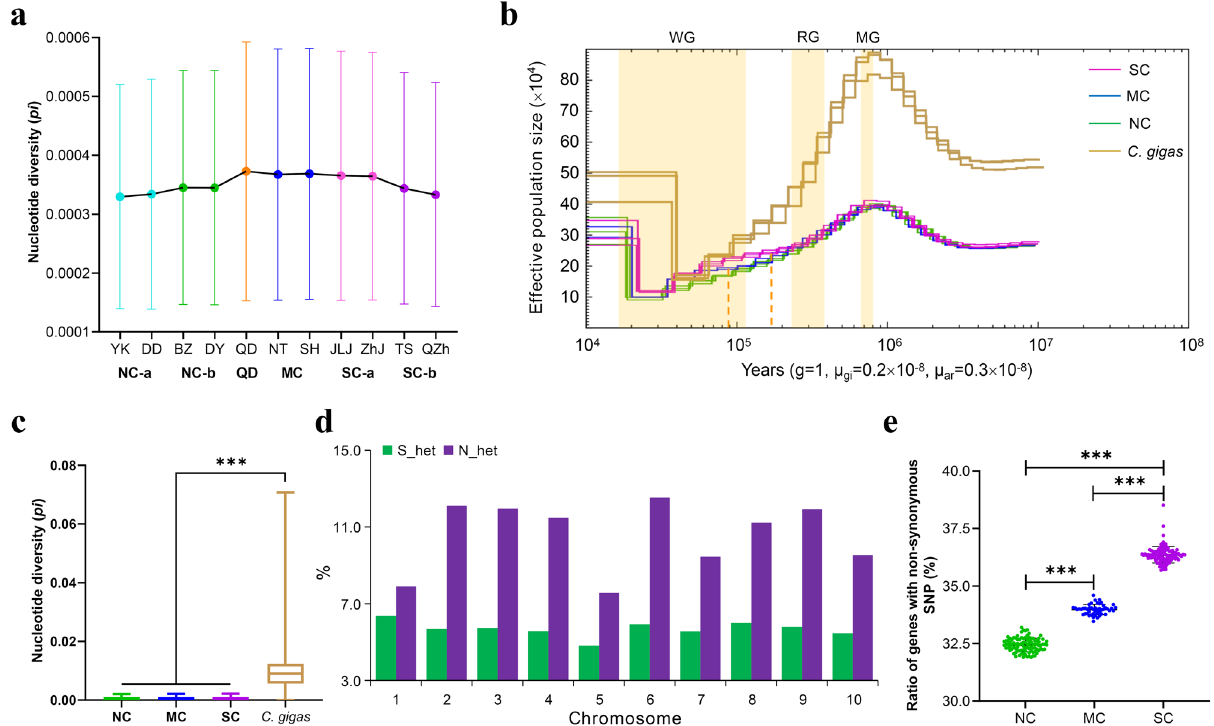
Fig. 3 Effects of gene fl ow, historical glaciation and natural selection on diversity and differentiation of the estuarine oyster. a Nucleotide diversity ( pi ) in 11 geographic populations along the coast of China. b Demographic histories of three populations of the estuarine oyster (ar) (SC, MC and NC), and Paci fi c oyster ( C. gigas or gi) inferred by Pairwise Sequentially Markovian Coalescent. Periods of the Mindel glaciation (MG, 0.68~0.80 mya), Riss glaciation (MG, 0.24~0.37 mya) and Würm glaciation (WG, 10,000~120,000 years ago) were shaded by yellow. c Nucleotide diversity ( pi ) of three populations of the estuarine oyster, and Paci fi c oyster ( C. gigas ). The data are presented as box plots; the central rectangle spans the fi rst to third quartiles of the distribution, and the ‘ whiskers ’ above and below the box show the maximum and minimum estimates. The line inside the rectangle shows the median, the circles represent outliers. d The ratio of SNPs that are highly heterozygous only in northern (N_het) or only in southern (S_het) populations across 10 chromosomes. e The ratio of genes with non-synonymous SNPs in three oyster populations. Data are presented as circle plot, with each circle representing an individual oyster and bars showing the mean value ± SEM. Asterisks indicate signi fi cant difference (*** p < 0.001). Error bars represent SEM